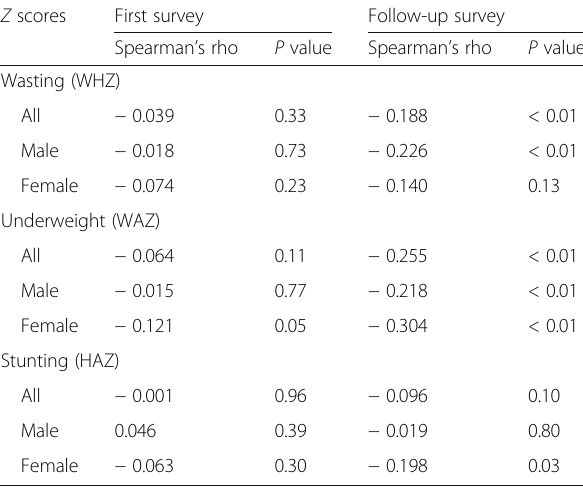
Table 3 Correlation of nutritional status with age of the